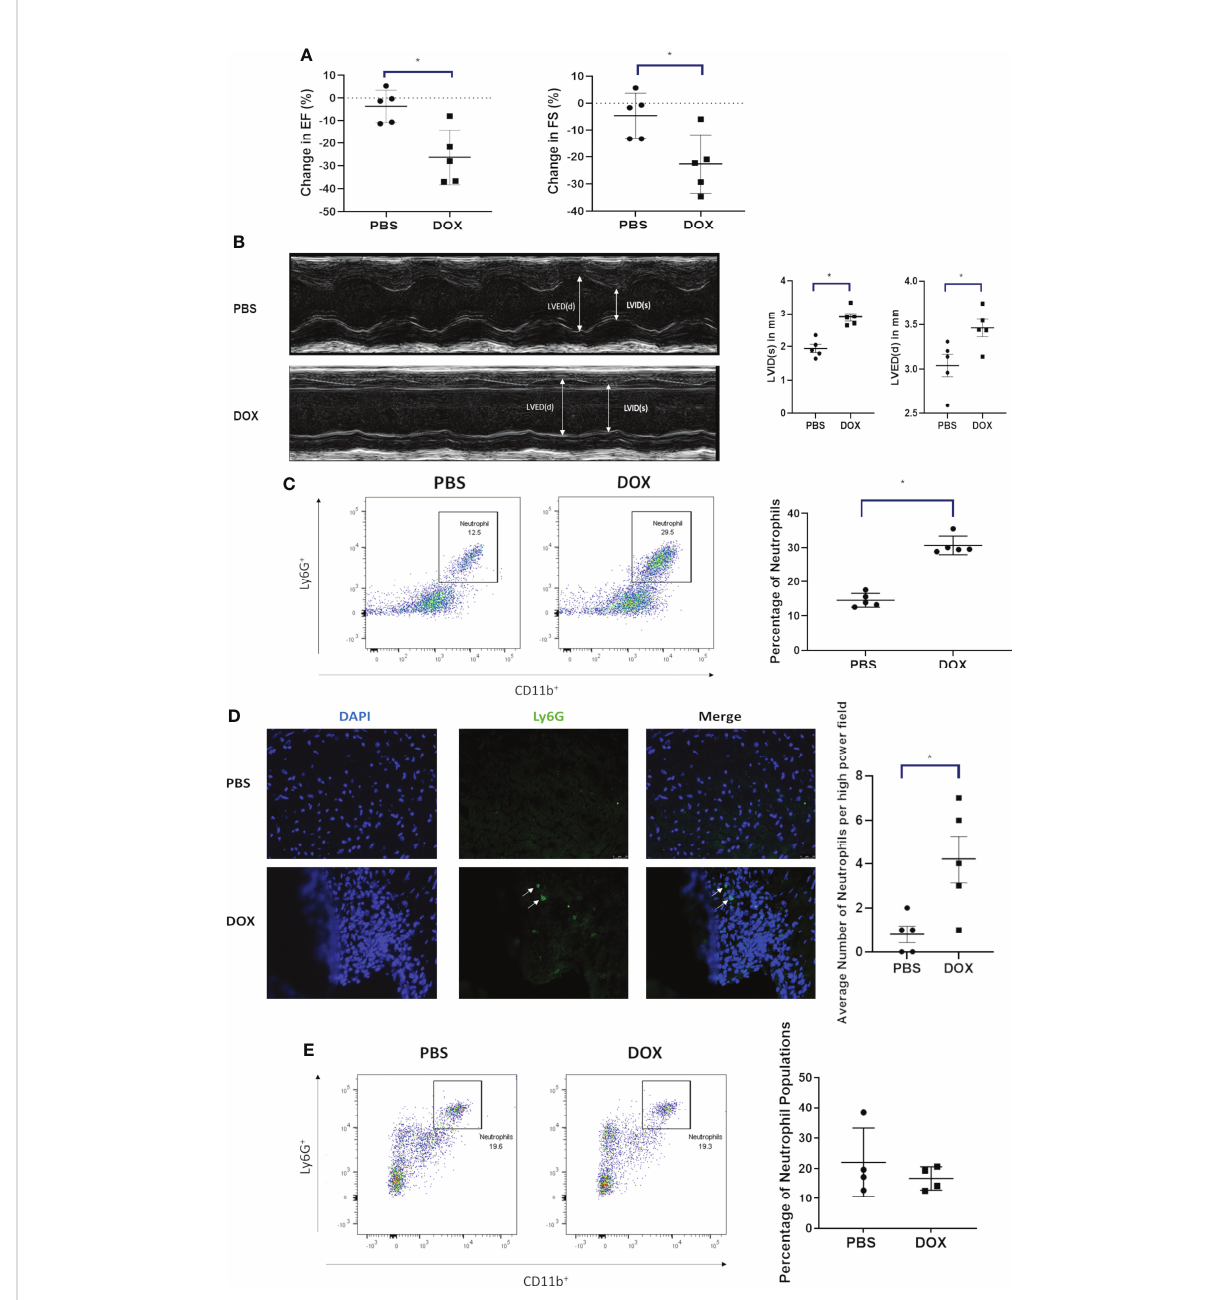
FIGURE 1 Effect of Doxorubicin (DOX) on heart function and neutrophil in fi ltration 24 h after therapy. (A) Ejection fraction (EF) and fractional shortening (FS) in mice were quanti fi ed by echocardiography 24 h after treatment with DOX or control phosphate-buffered saline (PBS); (B) Left ventricular internal dimension was measured in systole (LVID, s) and diastole (LVED,d). Data are presented as mean ± SEM, n=5 each, * p <0.05, a Mann-Whitney U-test was used to compare two groups.; (C) In fi ltration of neutrophils (CD11b+ Ly6G+ cells) in hearts of mice treated with DOX or control phosphate- buffered saline(PBS) was quanti fi ed by fl ow cytometry 24 h after therapy; (D) In fi ltration of neutrophils in hearts (Ly6G+) was quanti fi ed by immuno fl uorescence staining 24 h after therapy; (E) In fi ltration of neutrophils (CD11b+ Ly6G+) in hearts was quanti fi ed by fl ow cytometry 11 weeks after therapy. Data are presented as mean ± SEM, n=5 each, * p <0.05, a Mann-Whitney U-test was used to compare two